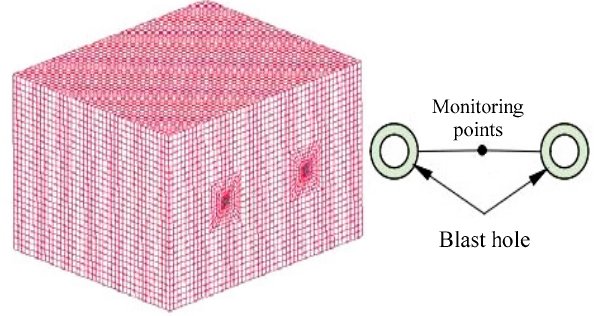
Figure 6. Numerical model of the shallow-hole blasting.